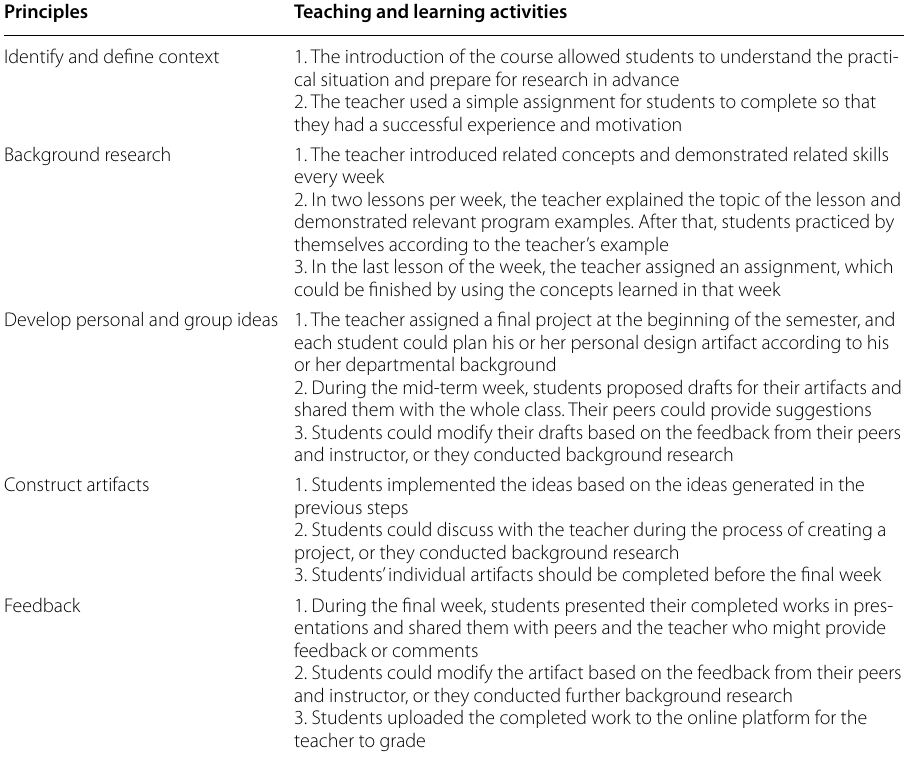
Table 2 The course design with the DBL